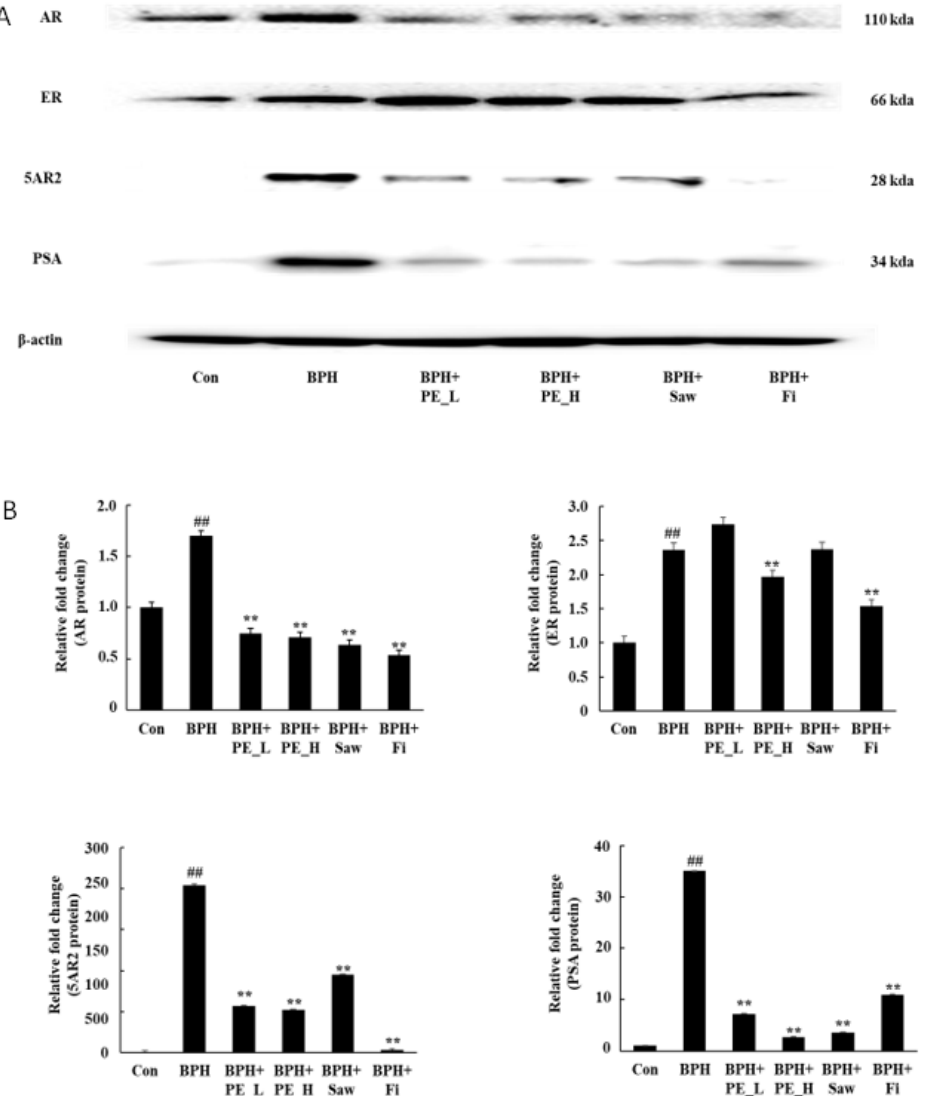
Figure 4. Expressions of AR, ER, 5AR2, and PSA proteins in prostate tissue. Note: Con, normal control control group; BPH, TP (3 mg / kg / d) / corn oil injection; BPH + PE_L, PE low dose treated BPH group; group; BPH, TP (3 mg/kg/d)/corn oil injection; BPH + PE_L, PE low dose treated BPH group; BPH + BPH + PE_L, 100 mg / kg of PE treated BPH group; BPH + PE_H, 200 mg / kg of PE treated BPH PE_L, 100 mg/kg of PE treated BPH group; BPH + PE_H, 200 mg/kg of PE treated BPH group; BPH +